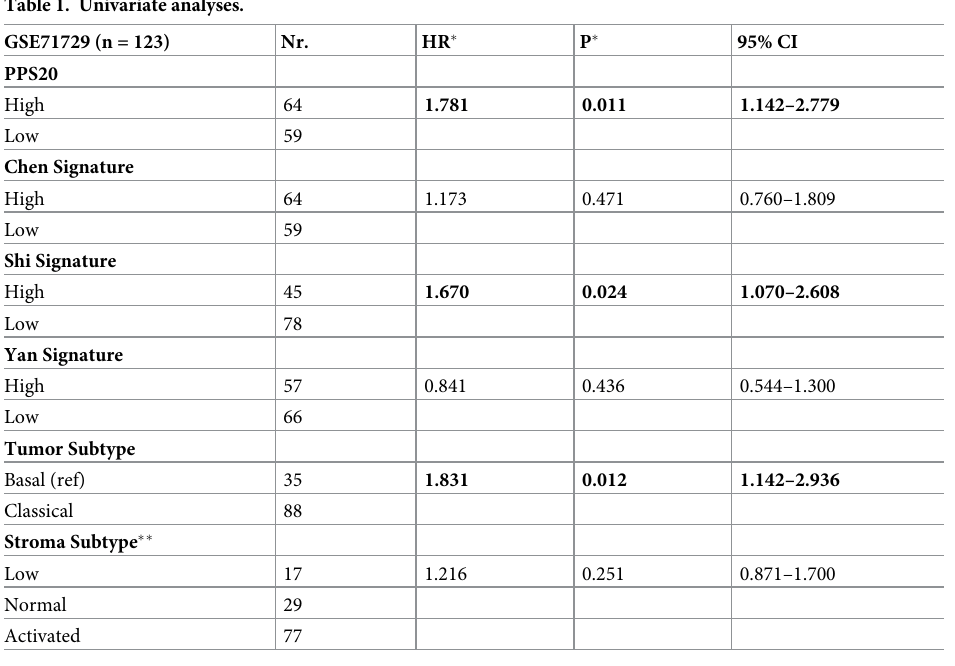
Table 1. Univariate